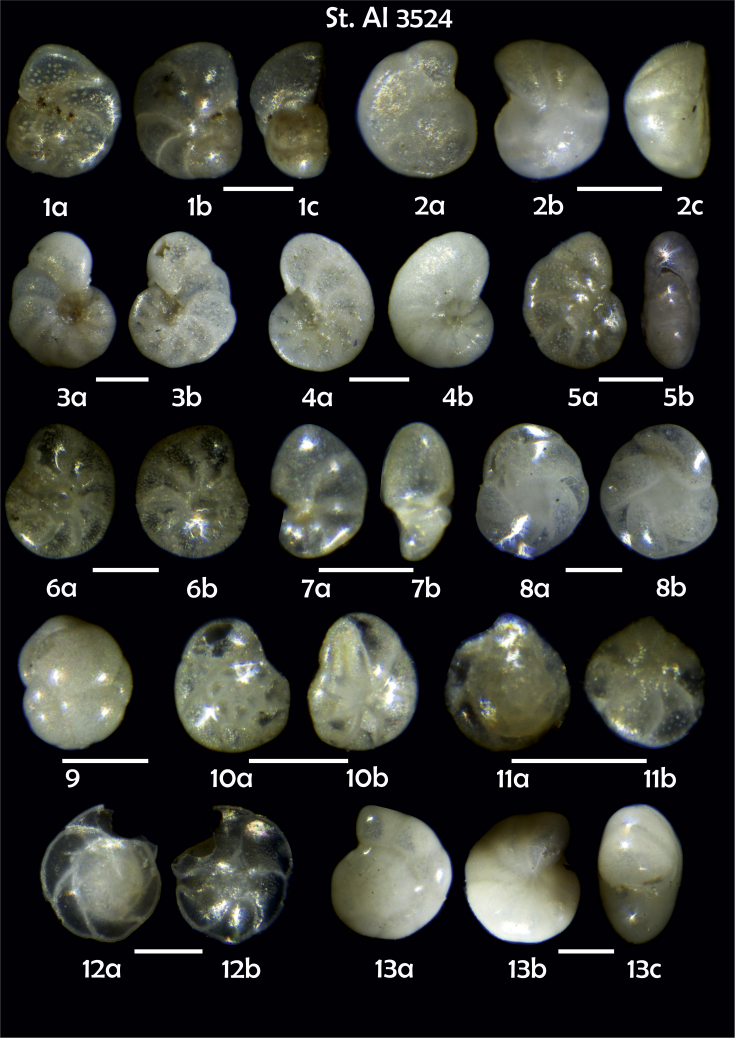
Station 35241Cibicidoides sp. juvenile form for C. lobatulus?, a umbilical view, b spiral view, c apertural view. 2Cibicides refulgens, a umbilical view, b spiral view, c apertural view. 3Cibicidoides sp., a umbilical view, b spiral view. 4Cibicidoides sp., a umbilical view, b spiral view. 5 ?, a lateral view, b apertural view. 6Elphidium excavatum, a umbilical view, b spiral view. 7Nonionella auricula,a lateral view, b apertural view. 8Cassidulina teretis, a apertural view, b lateral view. 9C. reniforme. 10Epistominella exigua, a spiral view, b umbilical view. 11Alabaminella weddellensis, a spiral view, b umbilical view. 12Gavelinopsis praegeri, a spiral view, b umbilical view. 13Oridorsalis sp. cf. O. umbonatus, a spiral view, b umbilical view, c apertural view. 14Fissurina staphyllearia. 15Fissurina sp. 16Bulimina mexicana. 17, 18Fursenkoina fusiformis. 19F. pausiloculata. 20Fursenkoina sp. cf. F. complanata. 21Brizalina subspinescens. 22Bolivina sp. 23, 24, 25Trifarina angulosa. 26Uvegerina peregrina. 27Bolivina pseudoplicata. 28Sigmoilopsis schlumbergeri. 29Reophax bradyi.30Psammosphaera fusca. Scale 100 μm.